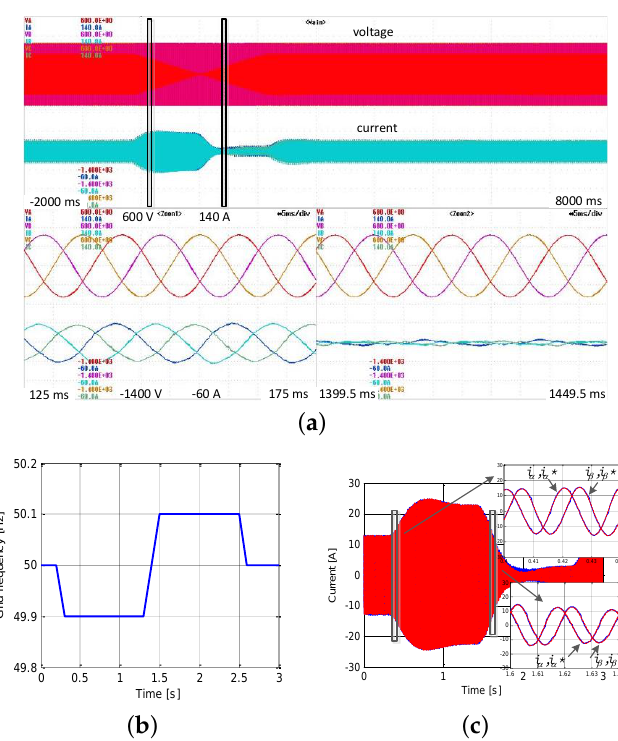
Figure 15. Experimental results of the SPC under grid frequency variations: ( a ) grid voltage and injected current; ( b ) the variation of grid frequency imposed by the AC regenerative power source; and ( c ) current reference and measurement on the α and β axis.